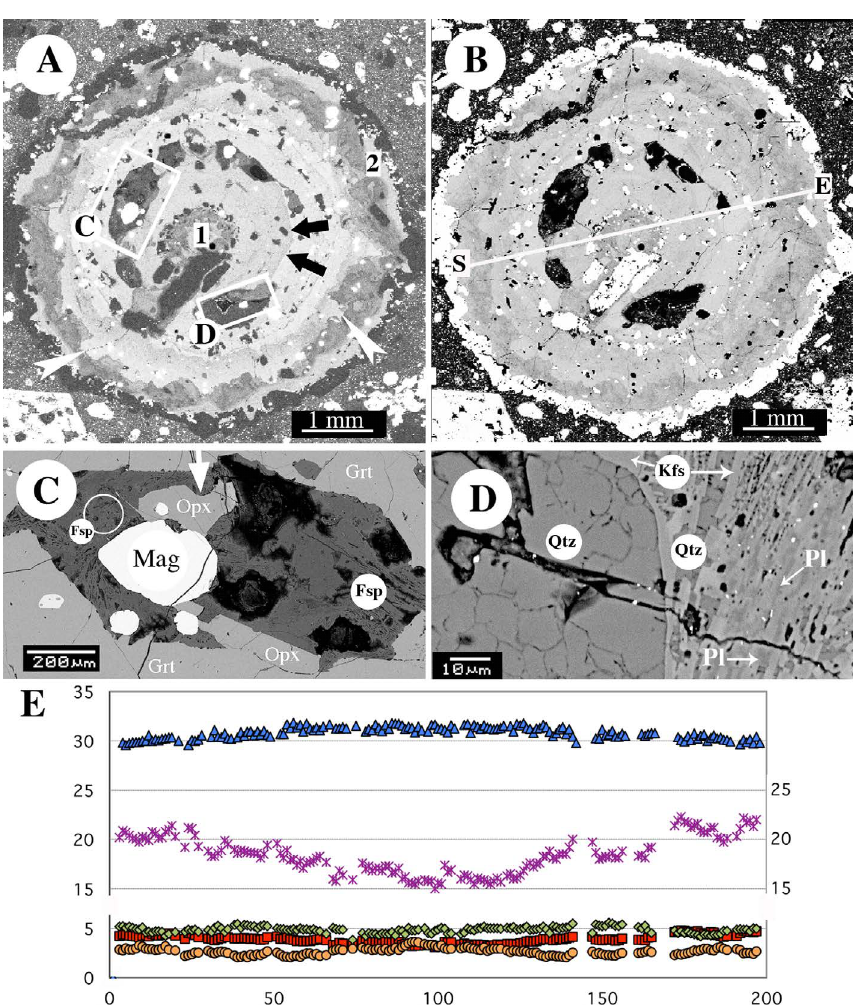
Figure 10: Details about the crystallised melt hollows cited in the text. [A] Ti X-Ray map of the subhedral, complexly zoned garnet megacryst. White rectangles (lettered C and D) outline large pools of crystallised melt, up to 2 mm long, that define a discontinuous ring discordant on the euhedral growth zoning (white arrows).